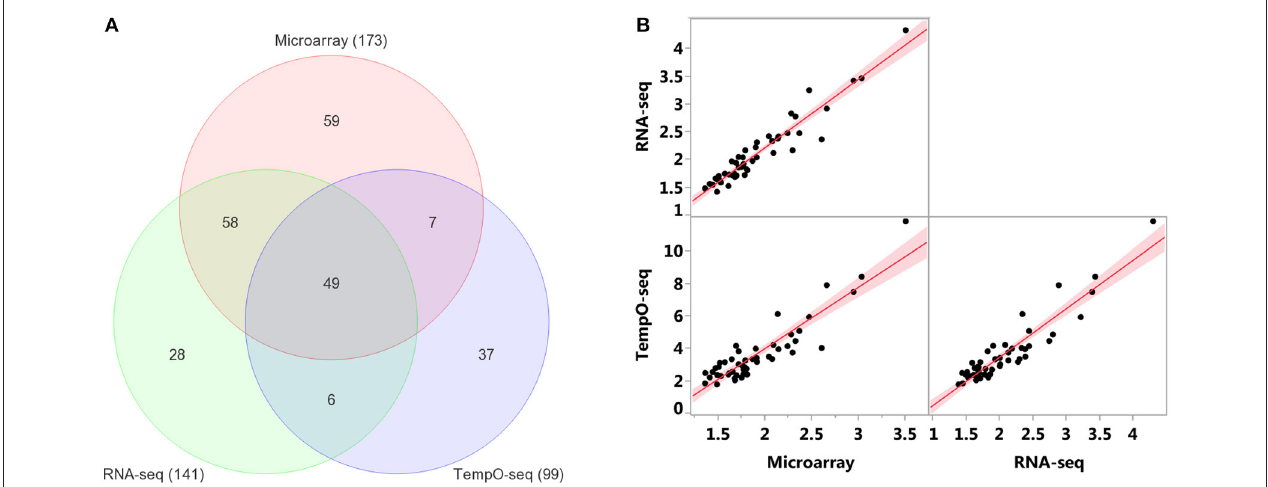
FIGURE 7 | Comparison of enriched GO biological processes (BPs). (A) Overlap of enriched GO BPs < FDR 5%. Minimum number of genes = 3 for TempO-Seq and 5 for the other two. (B) Pairwise comparison of GO BPs fold enrichment from the 49 categories in common between the three platforms. Red line is the linear fit (regression line) with 95% level confidence